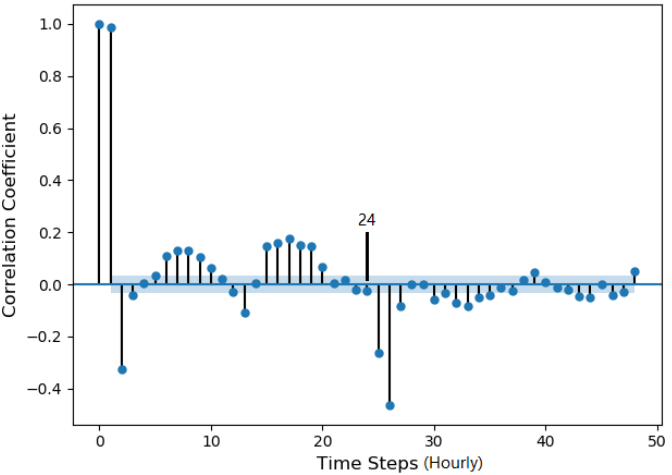
Figure 4. Partial autocorrelation of DO. The concentration of DO is collected